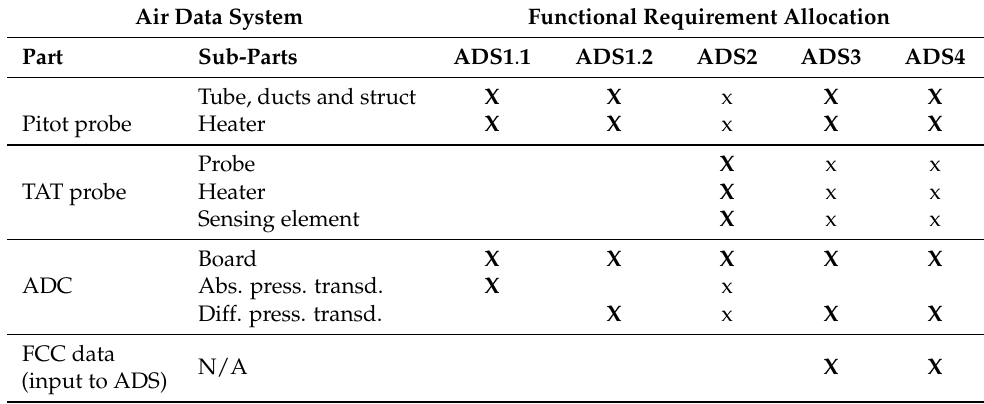
Table 3. ADS decomposition and functional requirement allocation to main parts. “ X ” represents a full loss, whereas “x” is a degraded